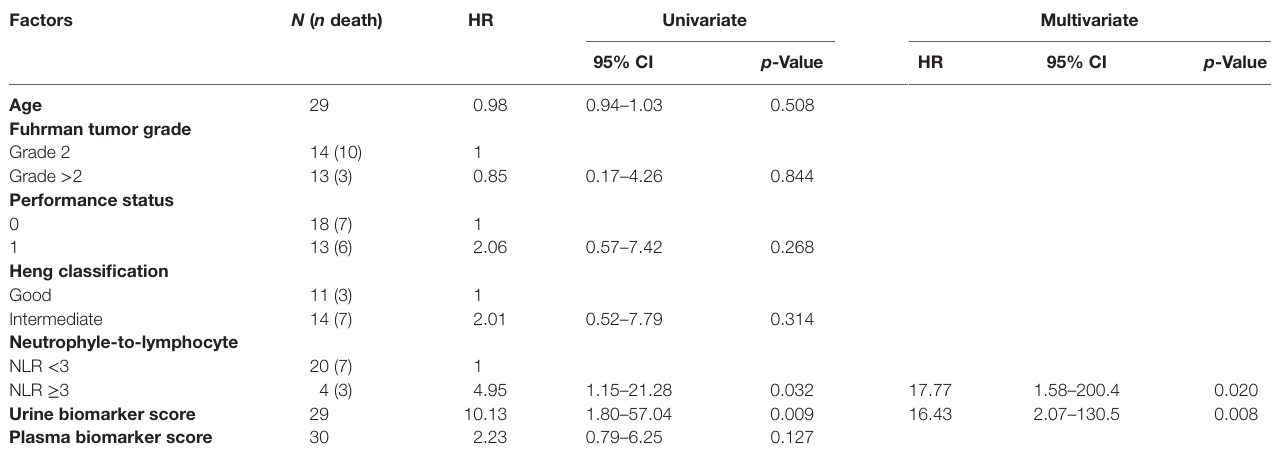
TaBle 3 | hazard ratio (hr) for clinical factors and Os (patients with missing scores were omitted). Factors N ( n death)